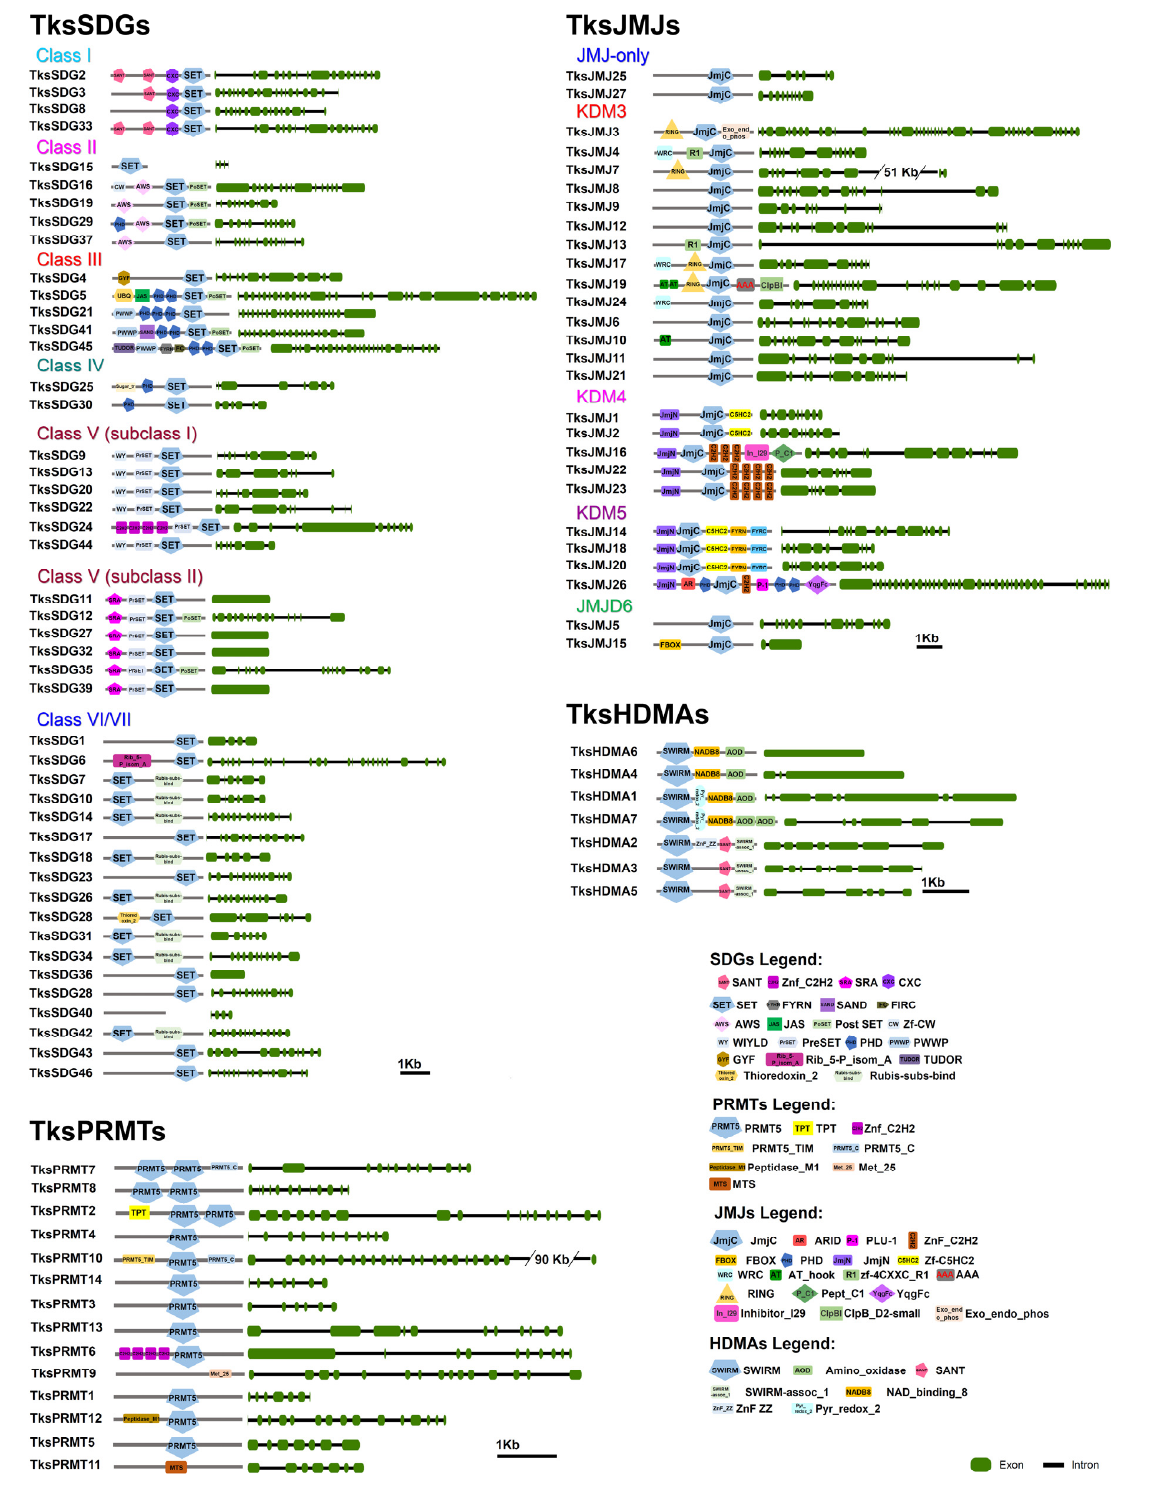
Figure 2. Domain composition and intron-exon structure of Taraxacum kok-saghyz HMTs and HDMs.